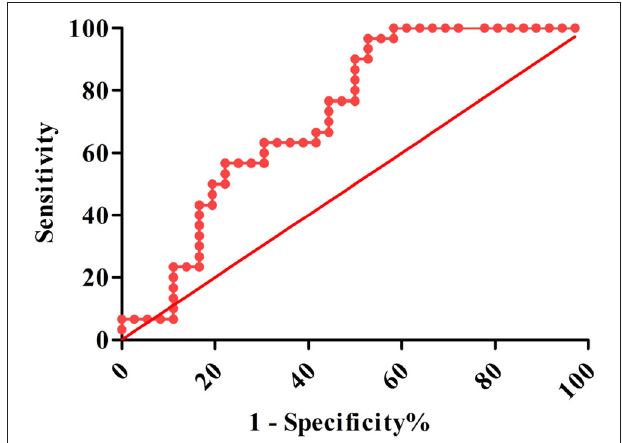
FIGURE 5 | ROC of plasm ghrelin level for diagnosis ARDS in sepsis.